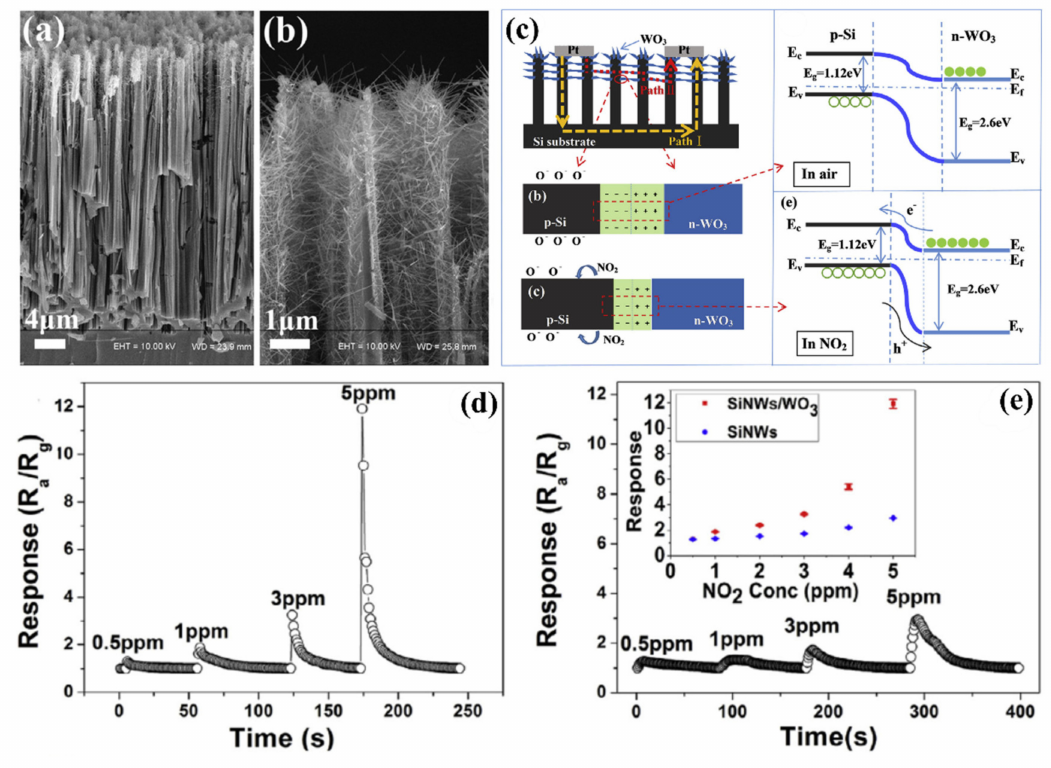
Figure 20. ( a , b ) The side view SEM images of SiNWs / WO 3 nanowires. ( c ) Schematic illustration for gas-sensing mechanism of SiNWs / WO 3 sensor, structural model, and heterostructure models and energy band diagrams in air and in NO 2 . Dynamic responses of the composite ( d ) and the pure SiNWs ( e ) to 0.5–5 ppm NO 2 at RT. Reproduced from [159], with permission from Elsevier,